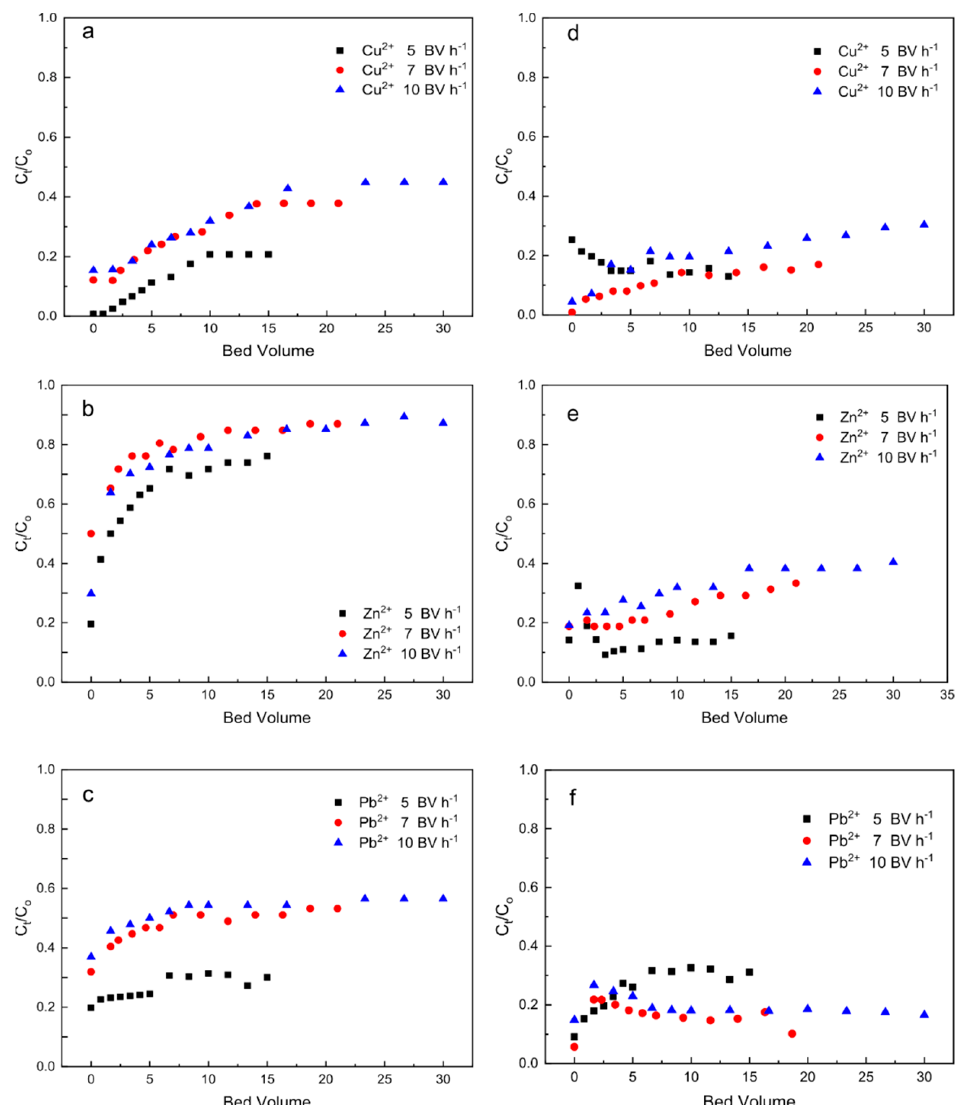
Figure 2. Breakthrough curves of clinoptilolite leaching Cu 2+ ( a ); Zn 2+ ( b ); Pb 2+ ( c ) and zeolite A leaching Cu 2+ ( d ); Zn 2+ ( e ); Pb 2+ ( f ) under 5 BV h − 1 , 7 BV h − 1 and 10 BV h − 1 .